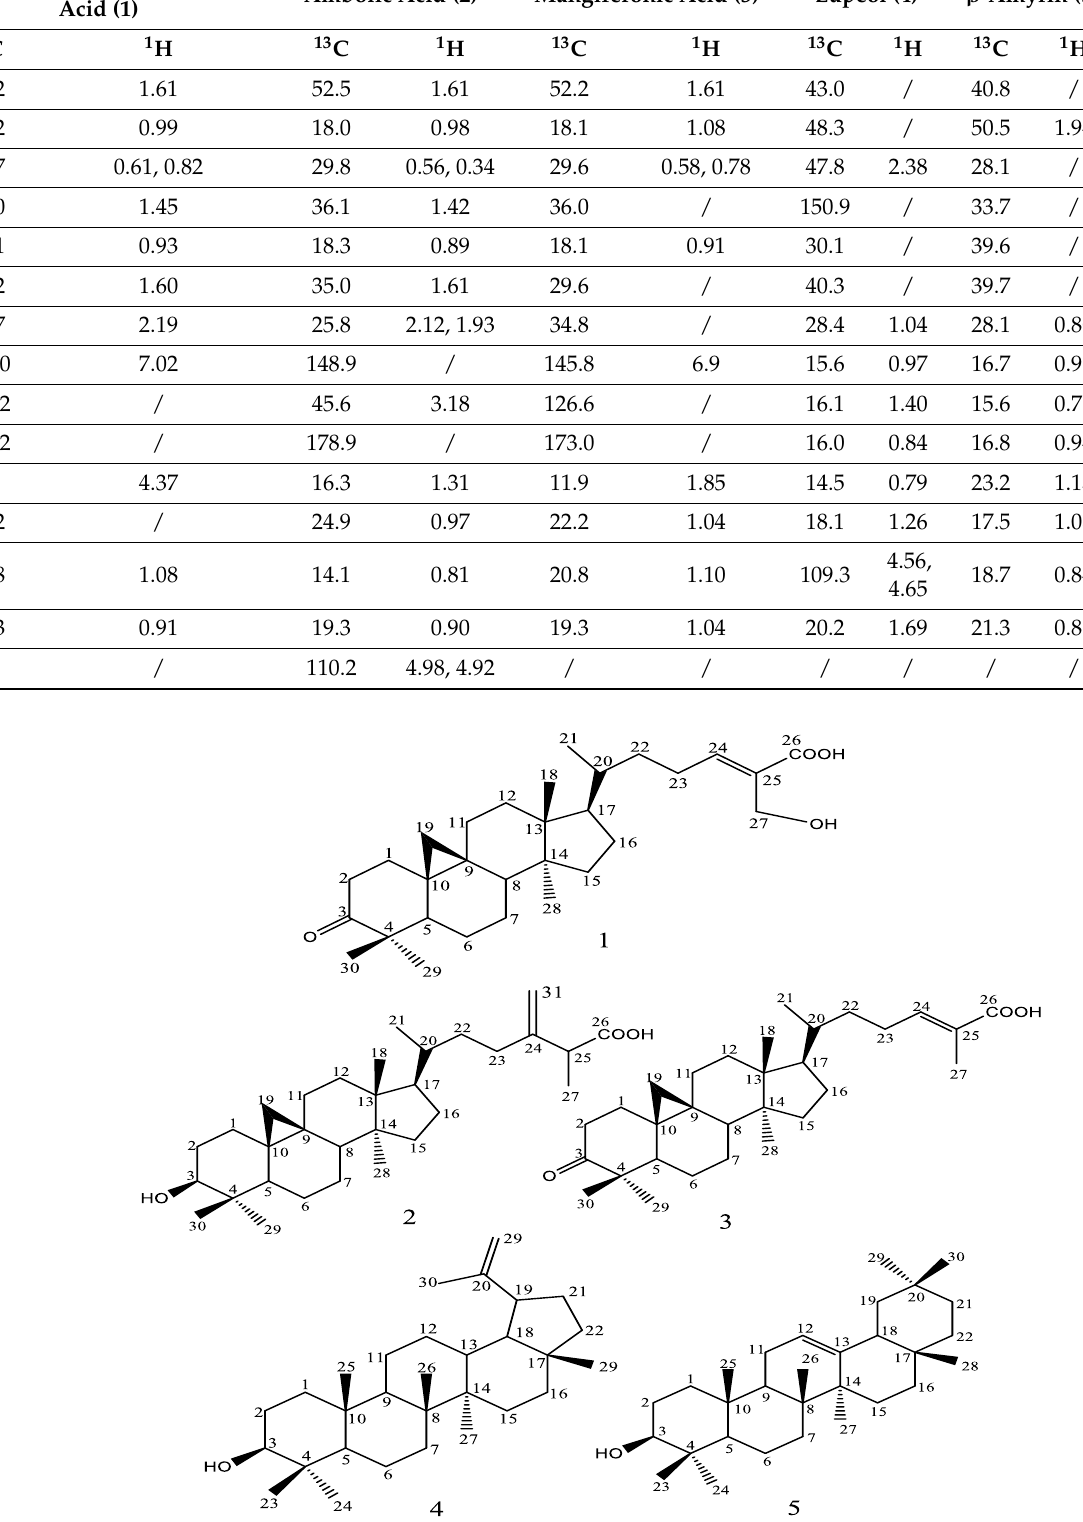
Figure 2. Structures of chemical compounds isolated from propolis sample; 27-Hydroxymangiferonic acid (1), Ambolic acid (2), Mangiferonic acid (3), Lupeol (4), β -amyrin (5).